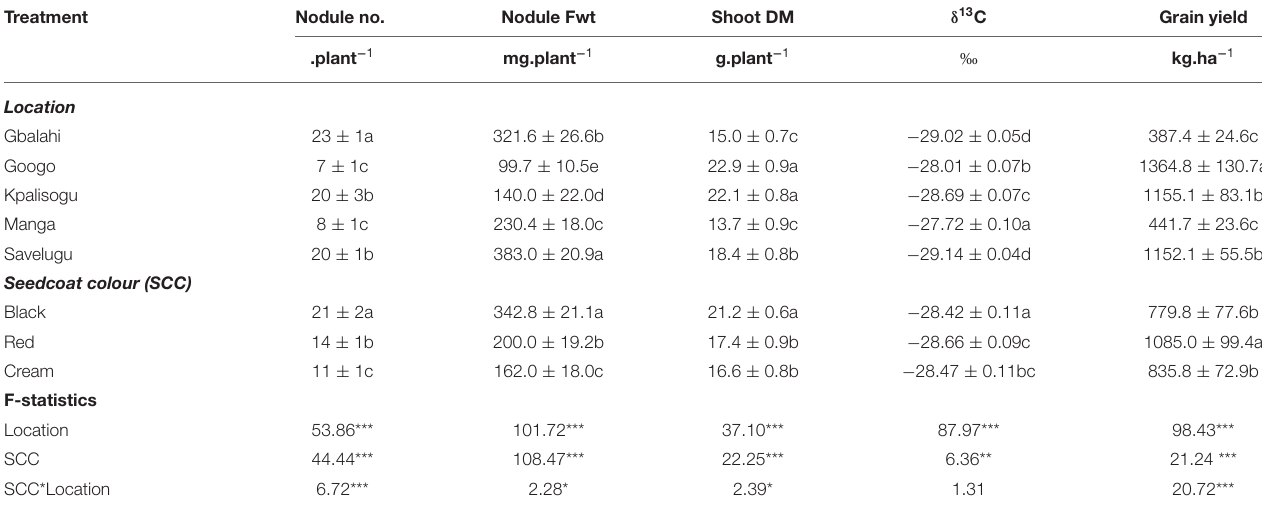
TABLE 6 | Effects of environment and seedcoat colour (SCC) on nodulation, shoot dry matter (DM), δ 13 C values and grain yield of Bambara groundnut landraces.